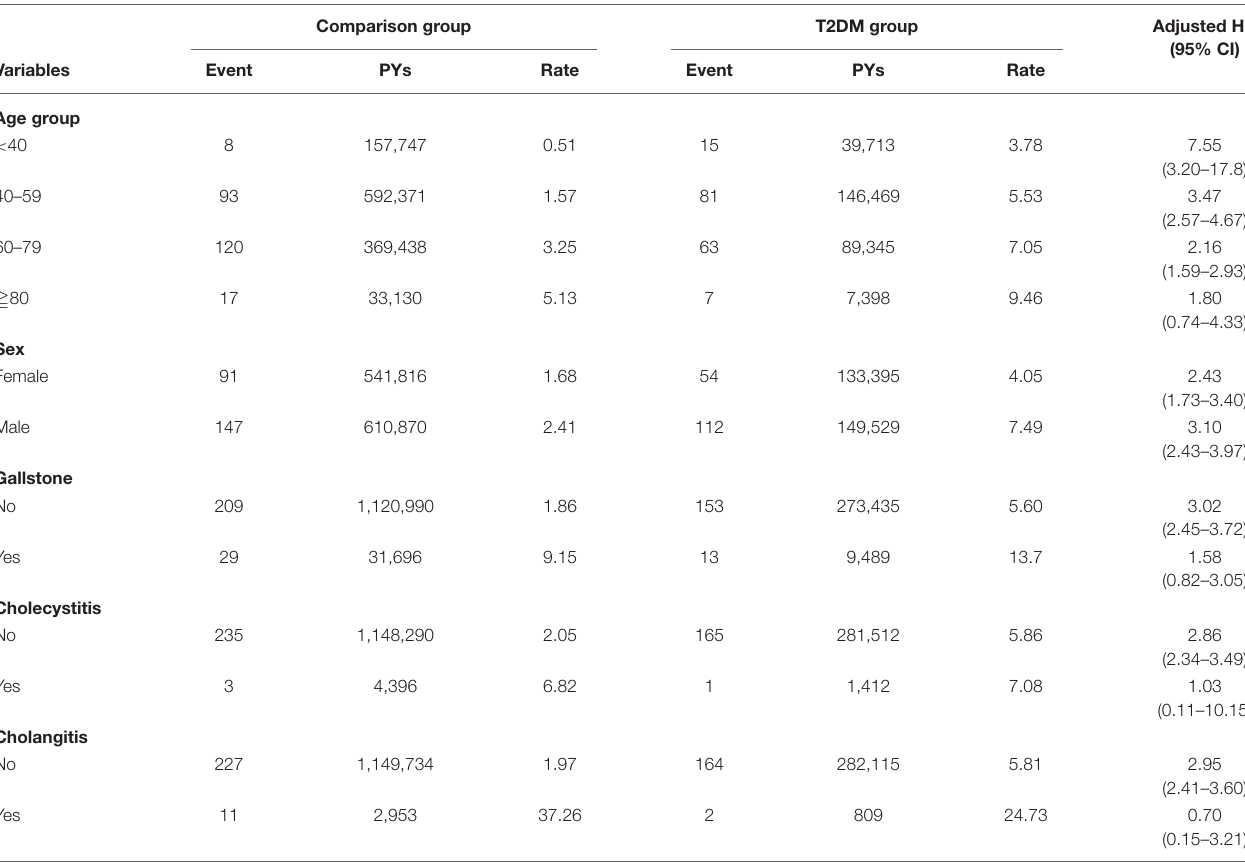
TABLE 4 | Demographic factor and comorbidity-stratified analysis of HR for PLA risk in comparison and DM cohort.